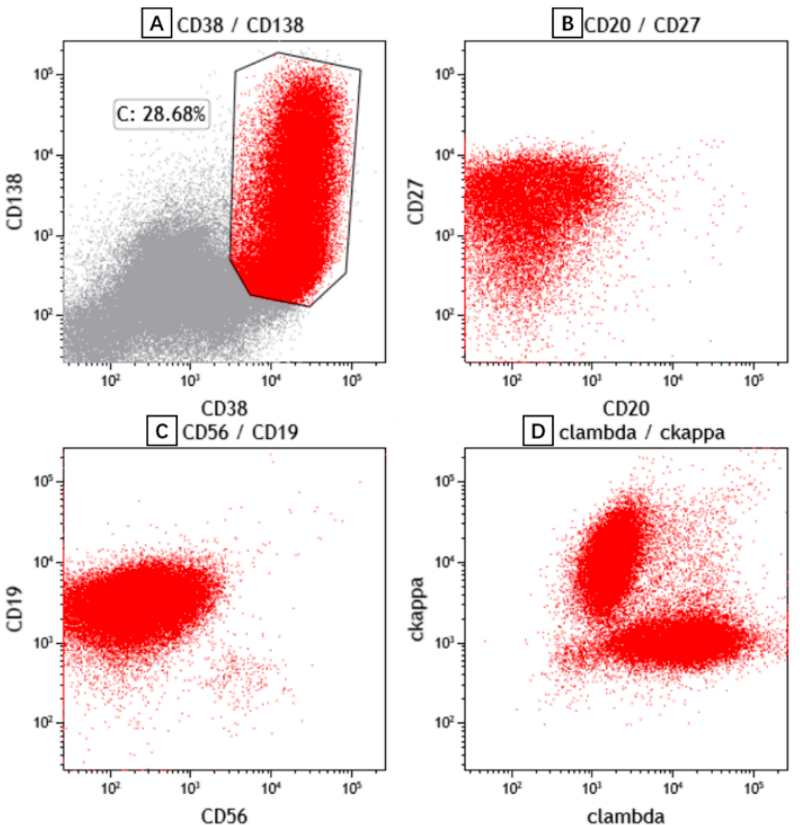
Figure 2. Representative scatter plots of bone marrow aspiration flow cytometric immunophenotyping. The plasma cells express CD38, CD138 ( A ), CD27 ( B ), CD19 ( C ) and polyclonal immunoglobulin light chain kappa and lambda ( D ).